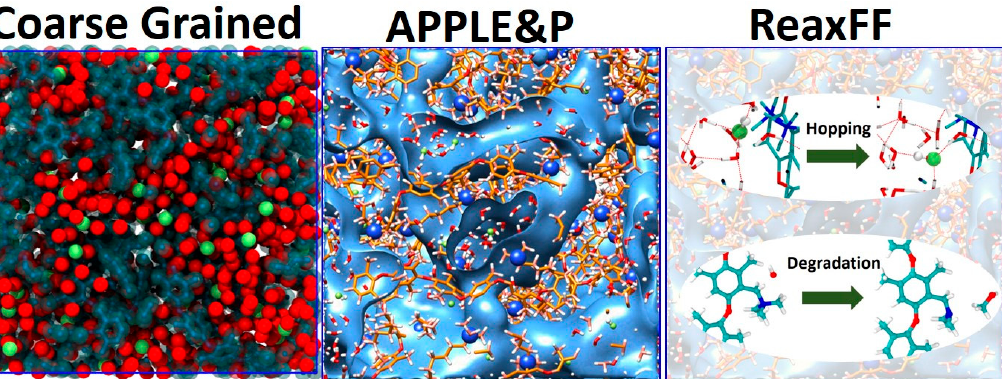
Figure 2. Illustration of combining simulations at different scales. The red dotted lines in the right panel indicate hydrogen bonds.